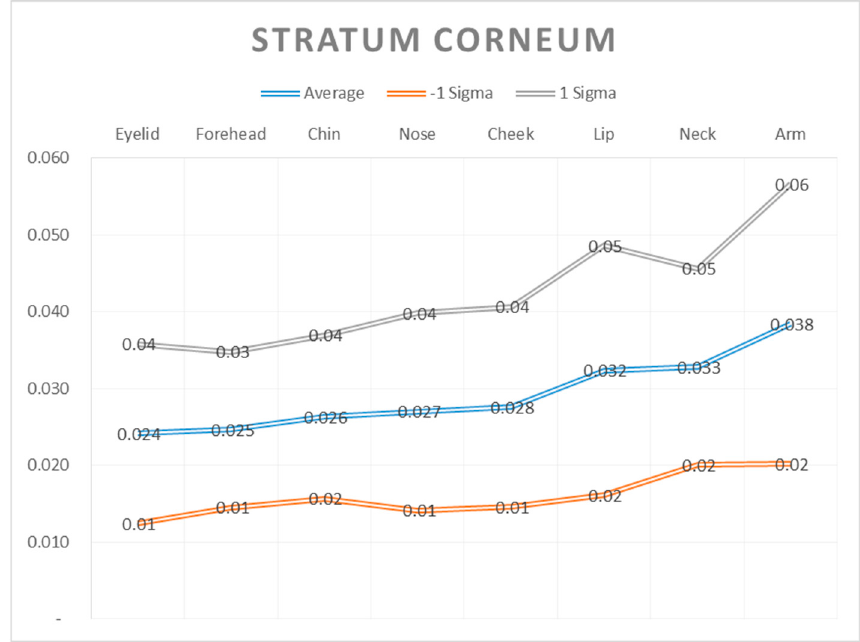
Figure 5. The average stratum corneum thickness of different skin sites.